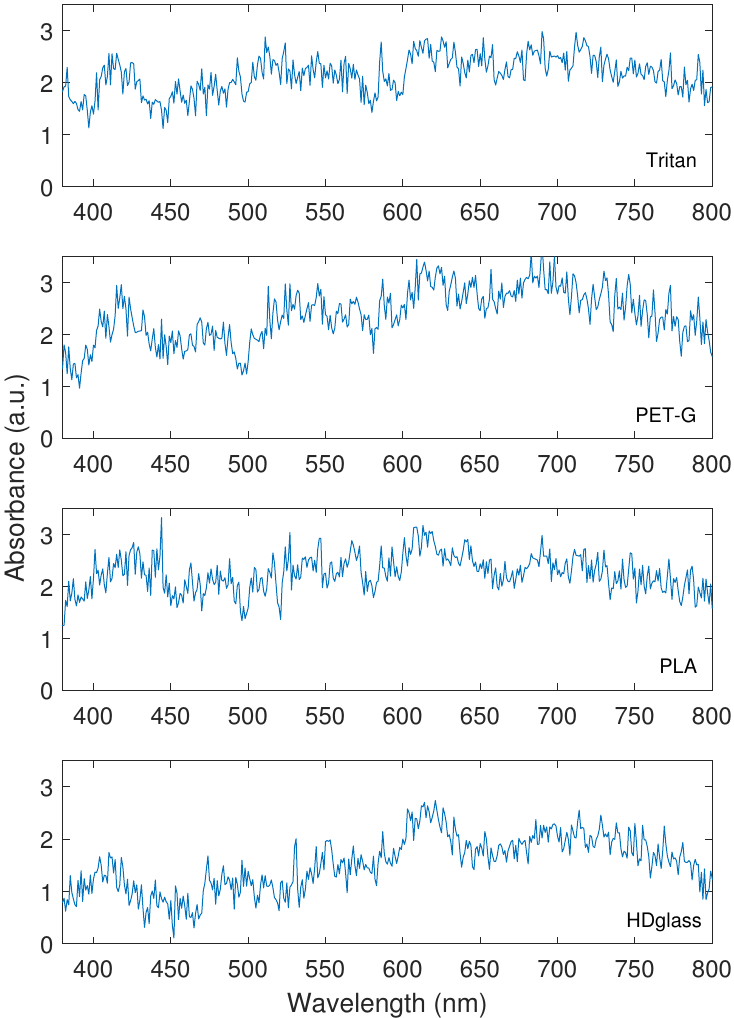
Figure 4. Filament absorbance values measured in the spectrophotometer for the wavelengths where the POFs have the smallest